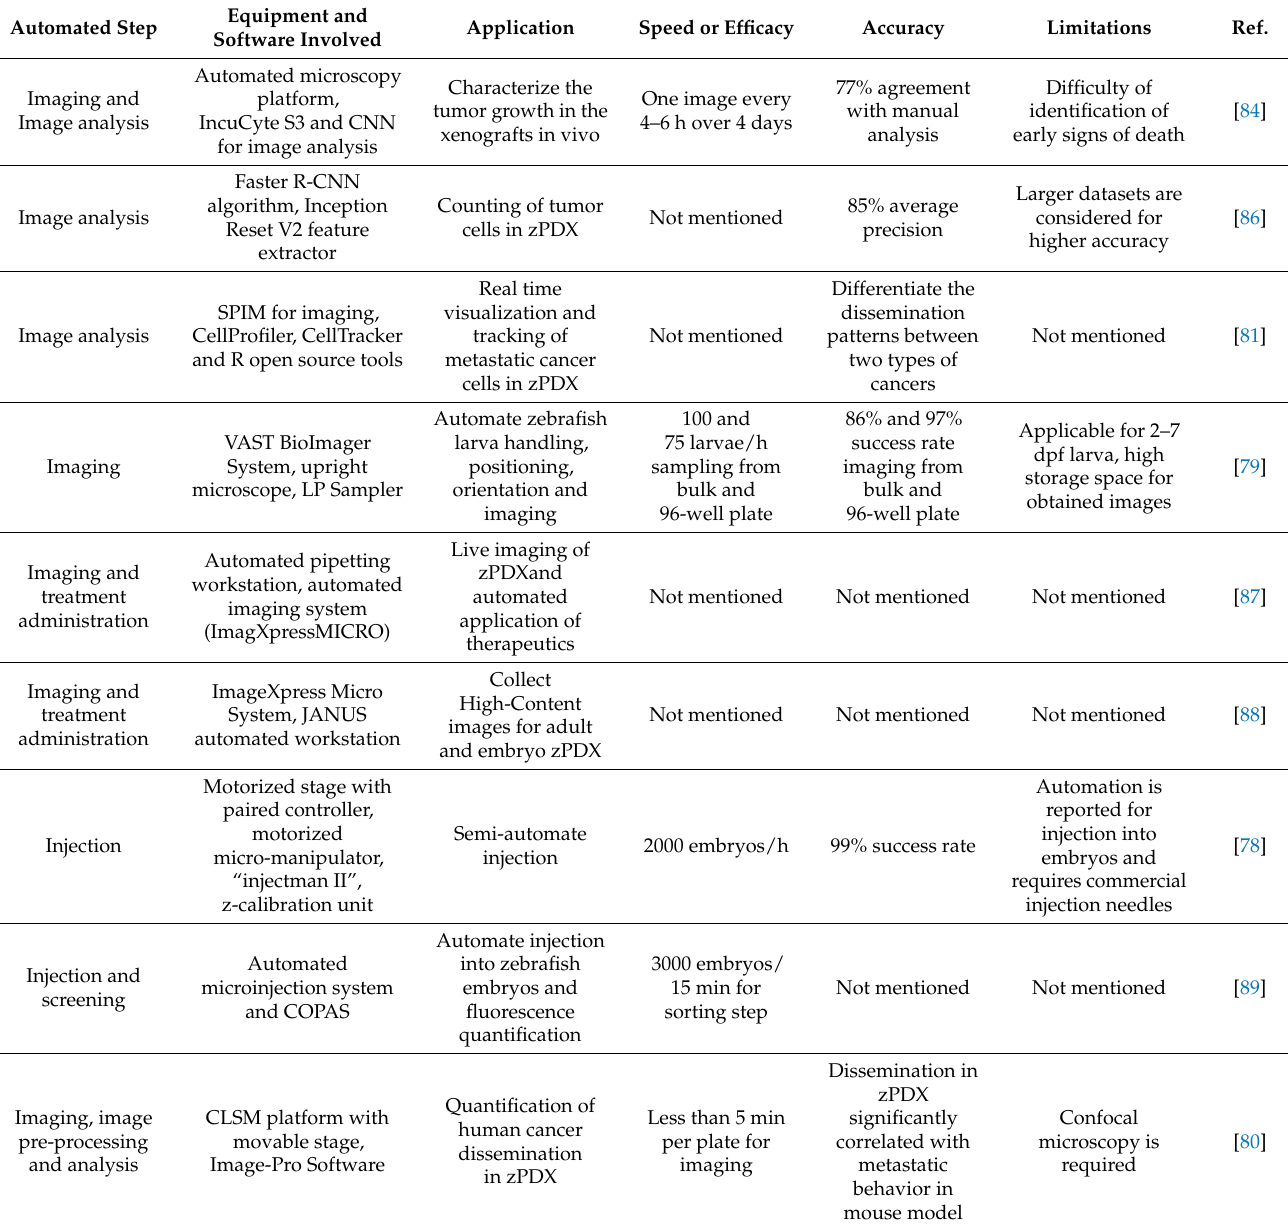
Table 1. Overview of automation approaches with potential application in